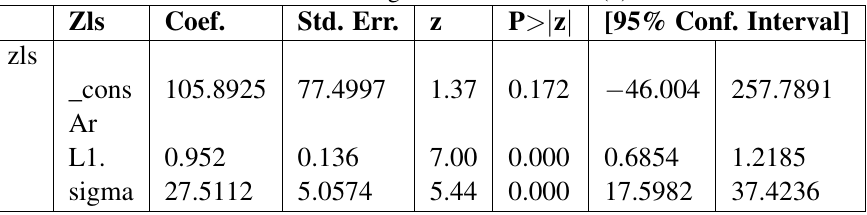
Table 5 The regression result of